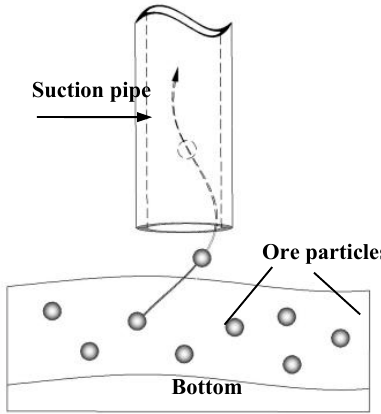
Figure 3. A Kind of hydraulic collecting model.